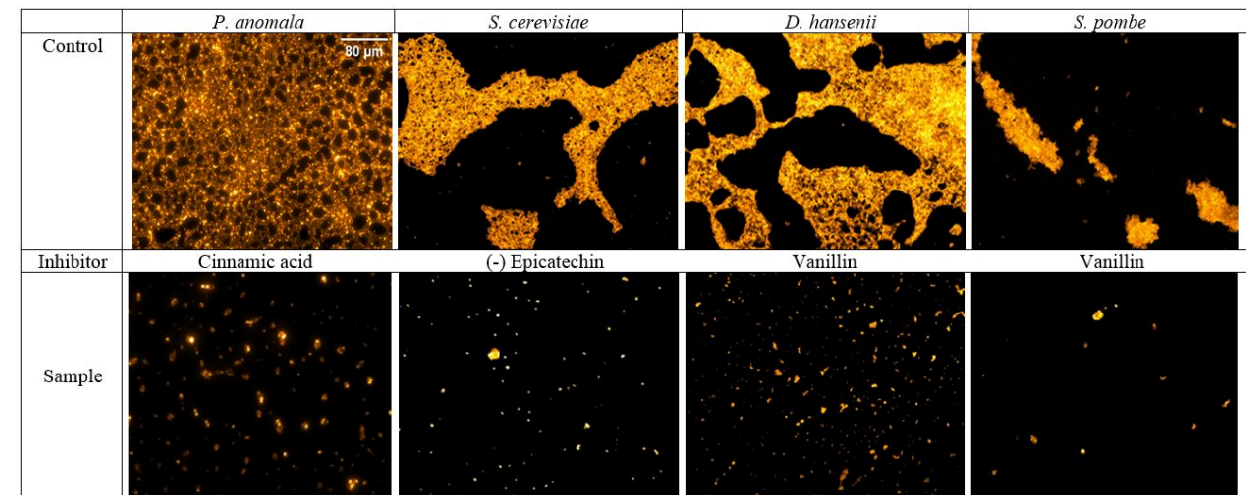
Figure 2. Biofilm formation of yeasts on a glass surface in the presence (sample) or absence (control) of selected phenolic compounds. Phenolic compounds were used in the samples at a concentration of 500 µg/mL. After an incubation at 30 °C for 24 h biofilms were stained with acridine orange and examined by fluorescence microscope. Magnification 20×.